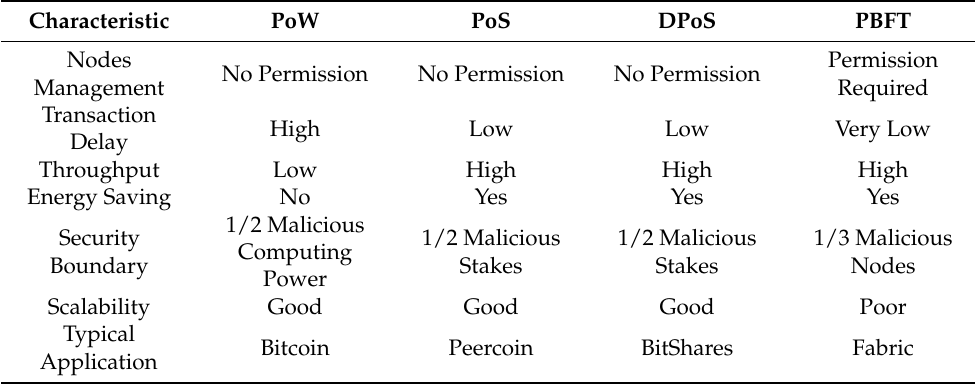
Table 1. Comparison of mainstream consensus